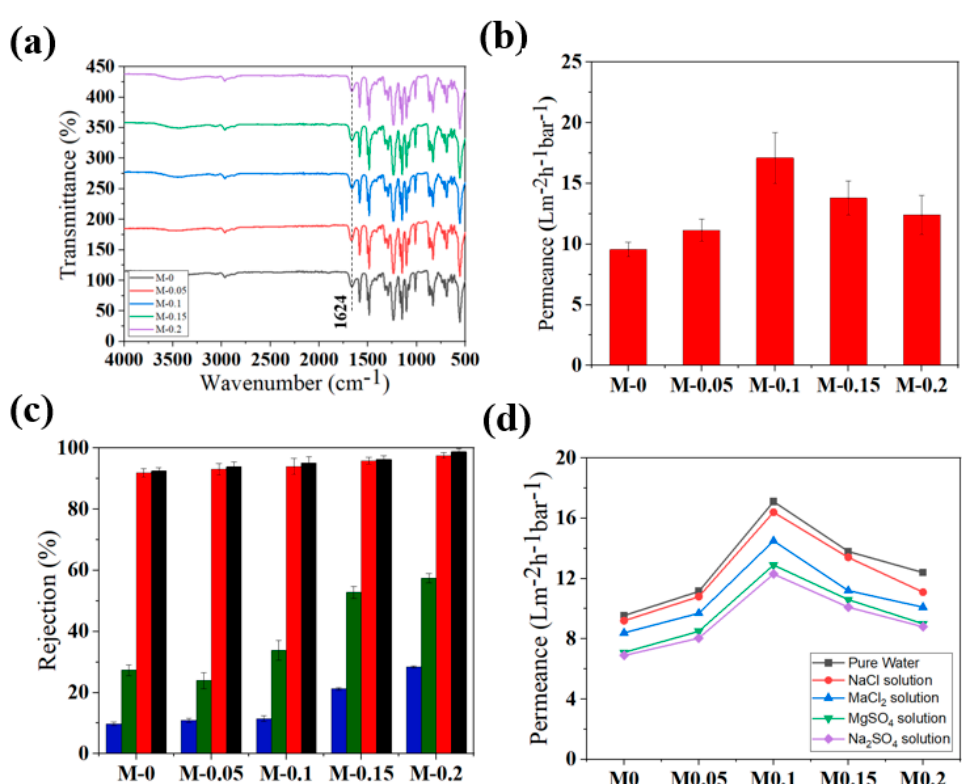
Figure 6. A comparison of ( a ) FTIR spectrum, ( b ) pure water permeance, ( c ) separation performance, and ( d ) salt solution permeance of NF membranes.